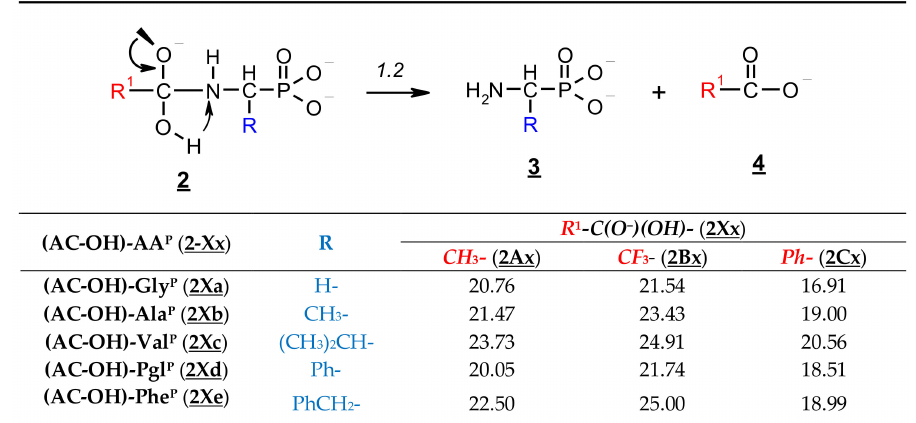
Table 8. Free energy barriers ( ∆ G ‡ (298 K), kcal/mol) for proton transfer/dissociation of the C-N bond in water (reaction 1.2 ).